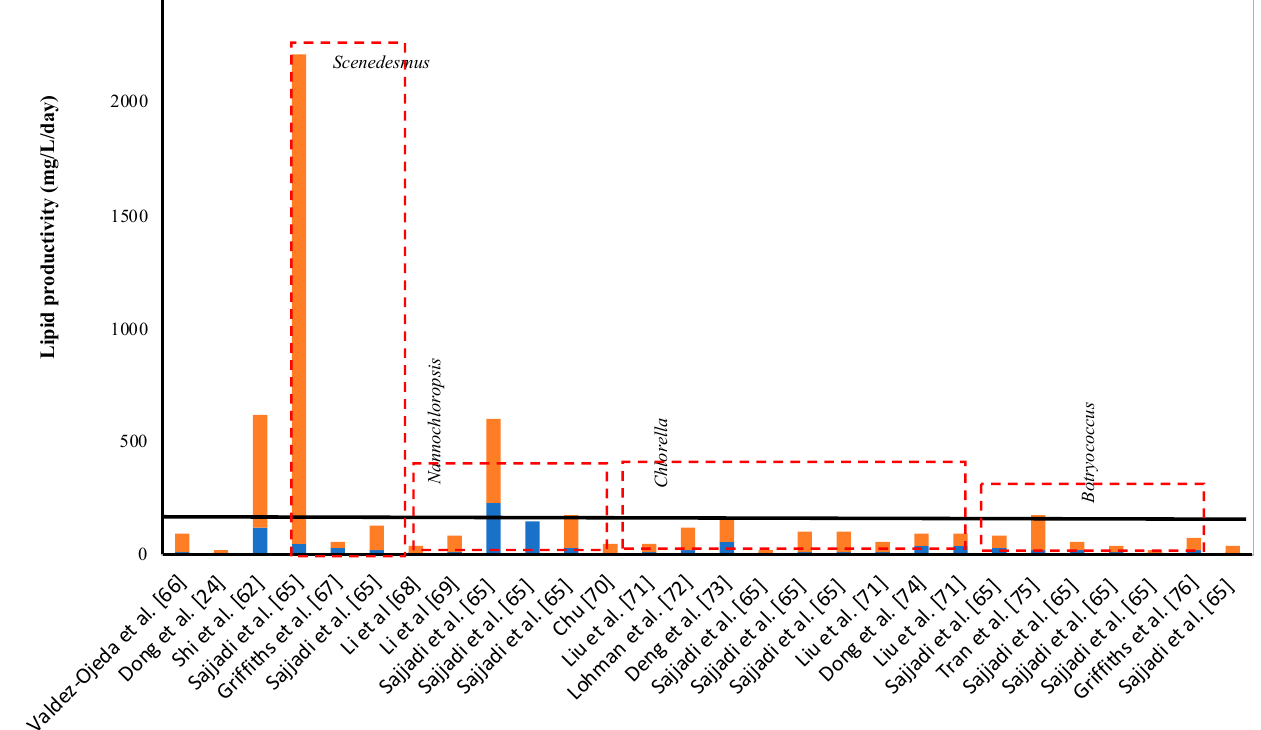
Figure 2. Lipid productivity of various species reported in the literature [24,62,65–76]. Two data bars (blue and orange) show the lowest and highest productivity of a particular species as given in that reference. The horizontal black line shows the average lipid productivity.